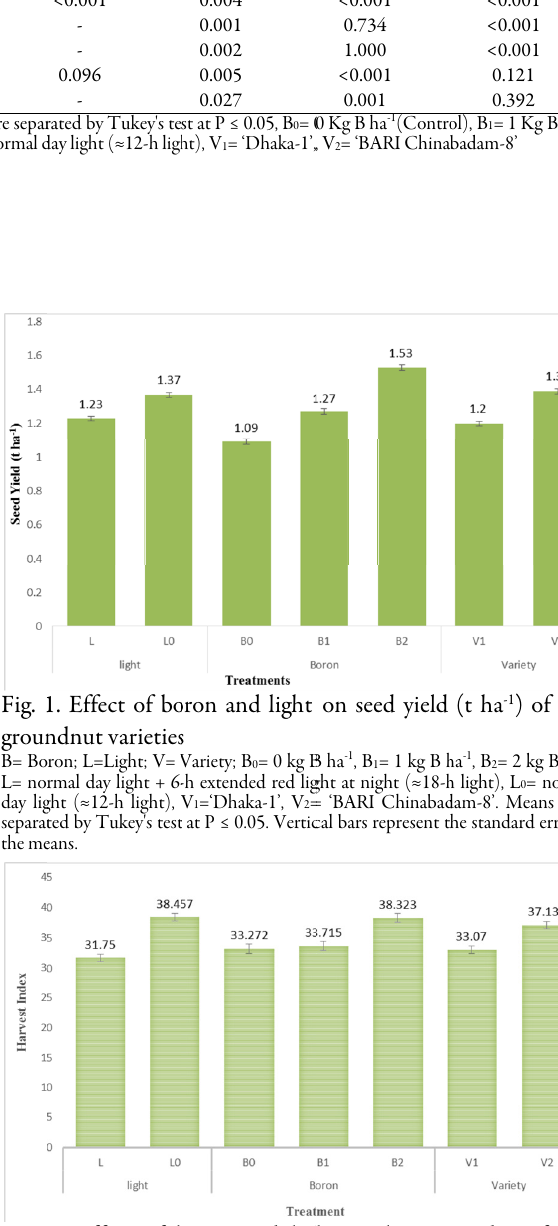
Fig. Effect of boron and light on harvest index of two groundnut varieties , B= Boron; L=Light; V= Variety; B 0 = 0 kg B ha -1 , B 1 = 1 kg B ha L= normal day light + 6-h extended red light at night (≈18-h light), L = normal day light (≈12-h light), V 1 =‘Dhaka-1’, V 2 = ‘BARI Chinabadam-8’. Means were separated by Tukey's test at P ≤ 0.05. Vertical bars represent the standard error of the means.